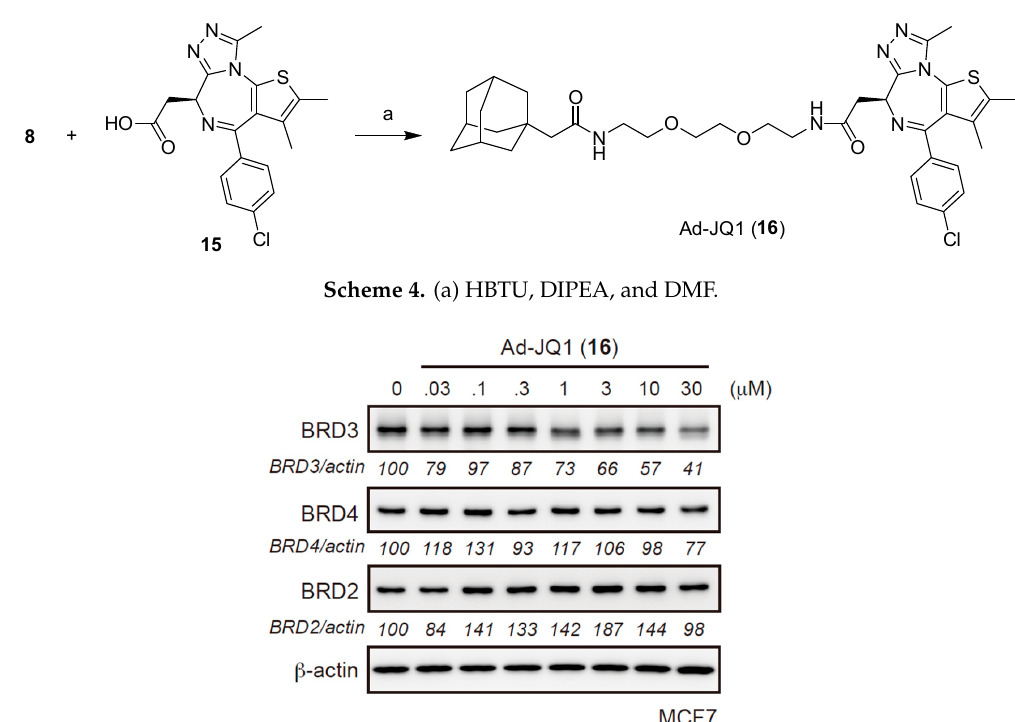
Figure 5. Ad-JQ1 ( 16 ) induces the degradation of BRD3 but not of BRD2 or BRD4. Protein knockdown activities of Ad-JQ1 in MCF-7 cells. Cells were treated with the indicated concentration of Ad-JQ1 for 48 h. Whole-cell lysates were analyzed by western blotting.